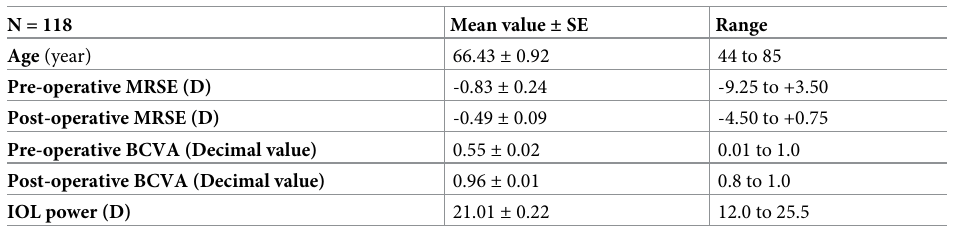
Table 1. Patient